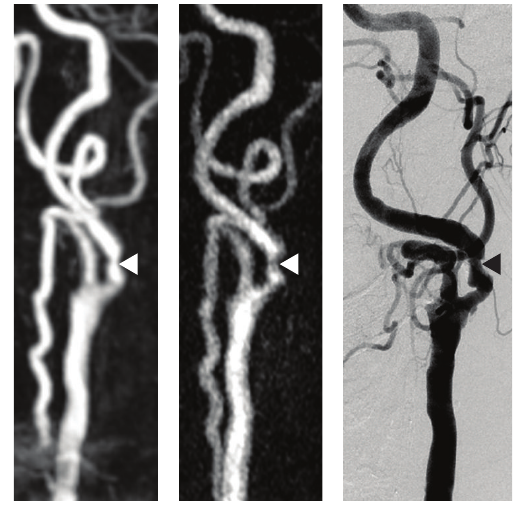
Figure 5: From left to right, conventional 3D-CE-MRA, TWIST- MRA obtained with the first bolus and DSA depicting a symp- tomatic and therefore hemodynamic relevant short stenosis of the left internal carotid